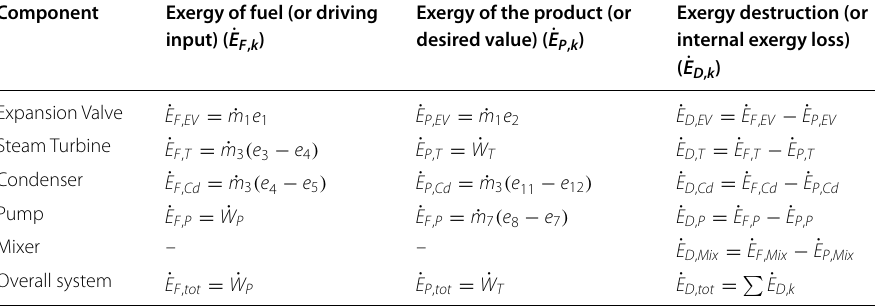
Table 1 Conventional exergy balance equations (Sun and Liu 2020)